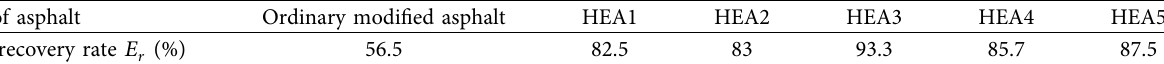
Table 3: Elastic recovery rates of different asphalt binders.